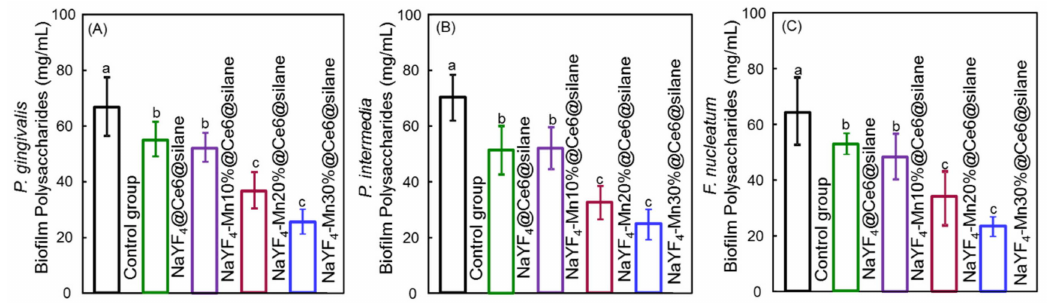
Figure 6. Polysaccharide production by 4-day biofilms of ( A ) P. gingivalis, ( B ) P. intermedia and ( C ) F. nucleatum on dentin squares (mean ± sd; n = 6). Dissimilar letters indicated significant di ff